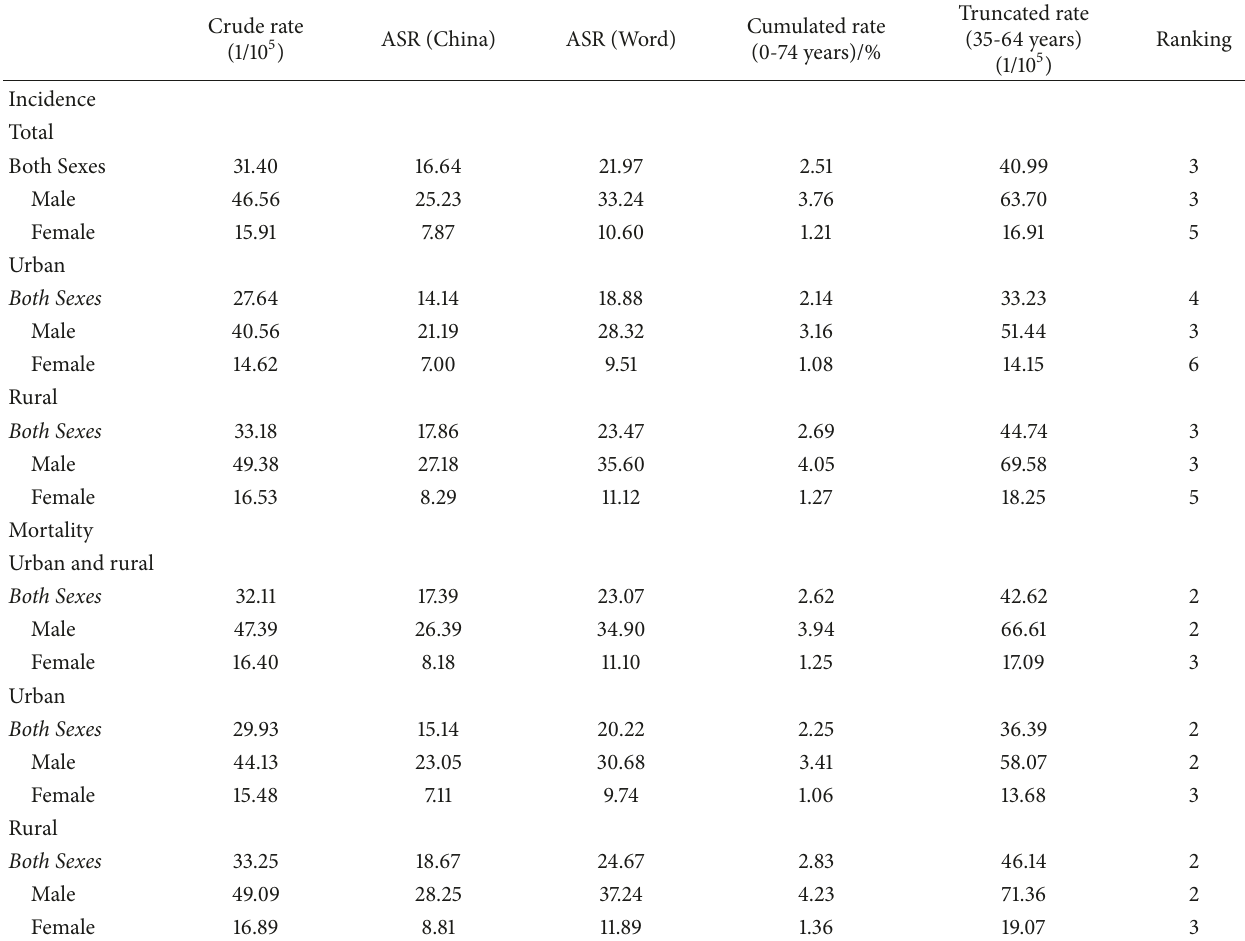
Table 1: The incidence and mortality rates of live cancer in Zhejiang province and their ranking among all cancers from 2005 to 2010.